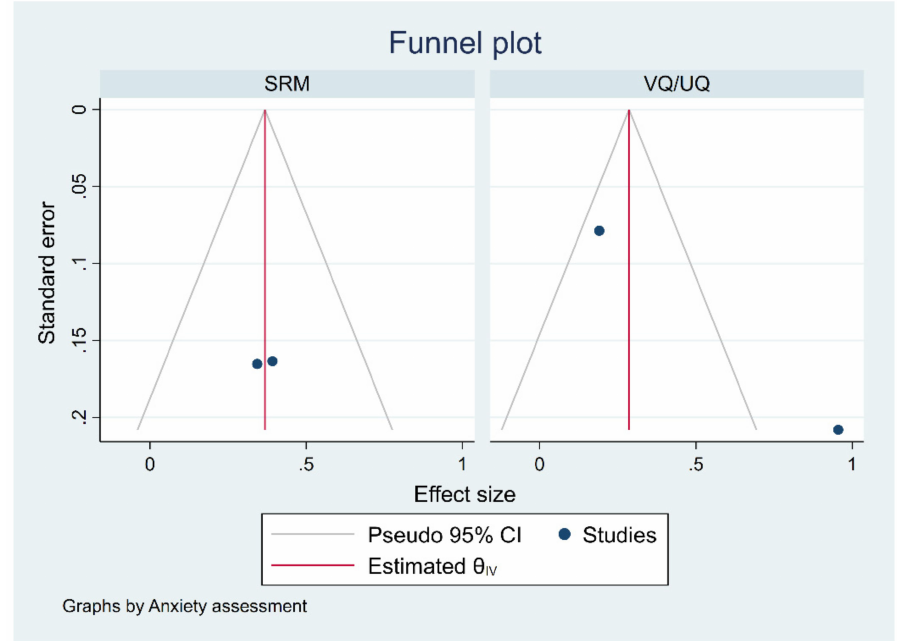
Figure A7. Funnel plot—anxiety disorder.